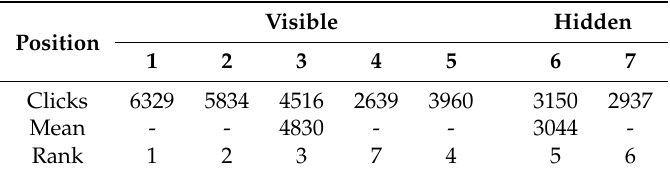
Table 2. Accumulated click-through by position in the recommendation ribbon and mean for the visible and invisible positions for the period from 15 October 2018 to 1 December 2018. Visible Hidden Position 1 2 3 4 5 6 7 Clicks 6329 5834 4516 2639 3960 3150 2937 Mean - - 4830 - - 3044 - Rank 6